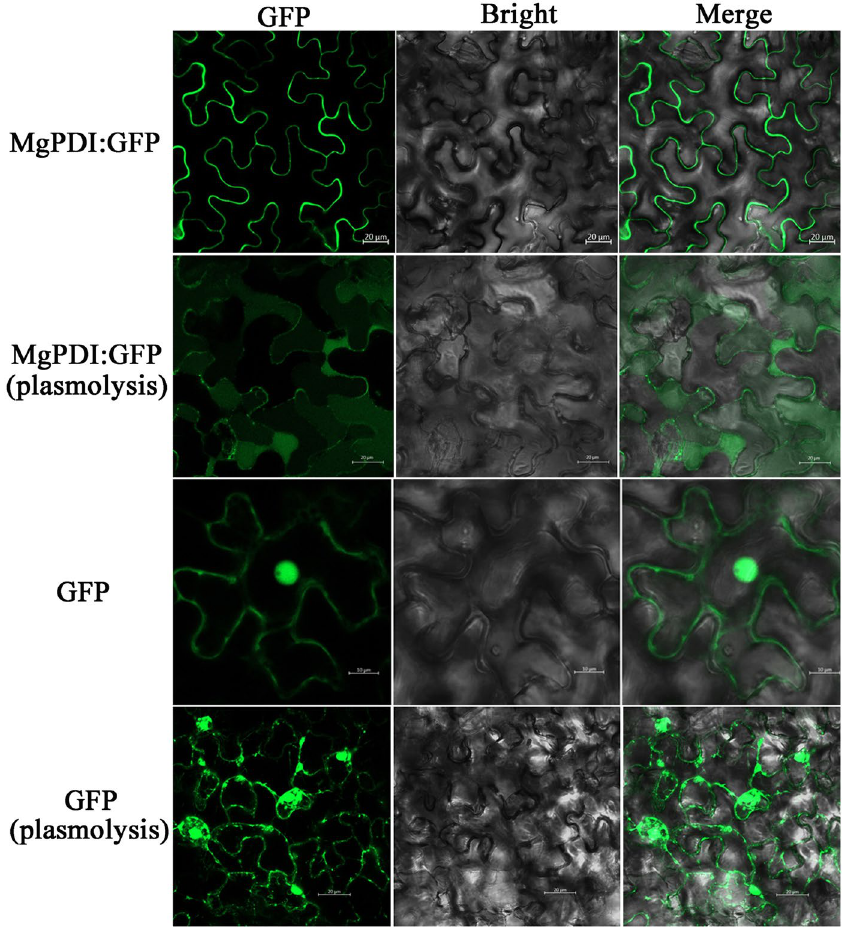
Figure 7. Subcellular localization of transiently expressed MgPDI:GFP fusions in N . benthamiana leaves. The first and third panel were MgPDI:GFP/GFP in normal cell, and the second and forth panel was MgPDI:GFP/ GFP in plasmolysed